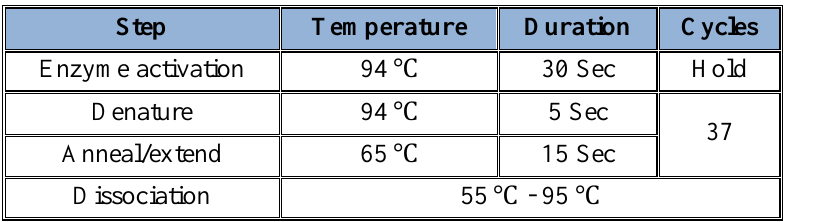
Table 5: Thermal profile of gene